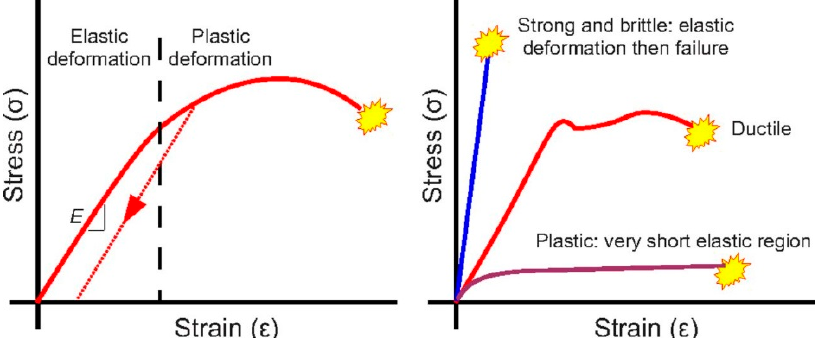
Figure 1. Stress/strain curves. Left panel : a classical curve, showing elastic and plastic regions, with hysteresis (dashed line); one deformation enters the plastic range—the material does not regain the original shape when the stressor is removed. Right panel : stress–strain curves for a variety of different materials (and possibly organisms).